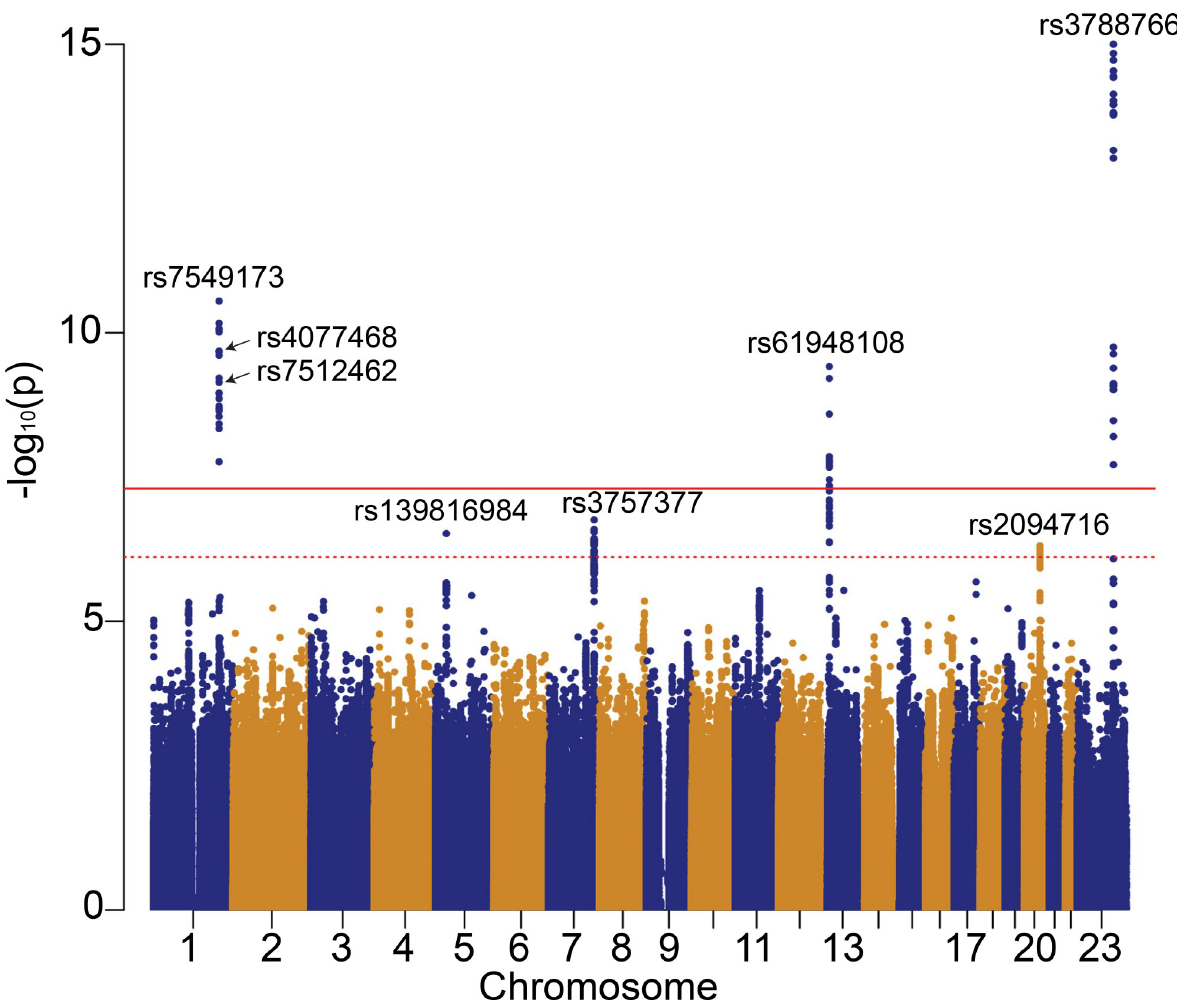
Fig 1. Manhattan plot for the genome-wide association study with meconium ileus in the GMC sample of 6,770 individuals with CF. All variants with MAF > 1% are included in the analysis. The solid horizontal line corresponds to the genome-wide significance threshold of p = 5x10 -8 [30], and the dotted horizontal line is the false discovery rate control threshold of q = 0.05 (equivalent to p < 7.67x10 -7 ) [31] . Accuracy of p-value calculation was up to 2.2x10 -16 by the geeglm function [100] in R. Variants rs4077468 and rs7512462 identified in previous CF gene modifier studies also